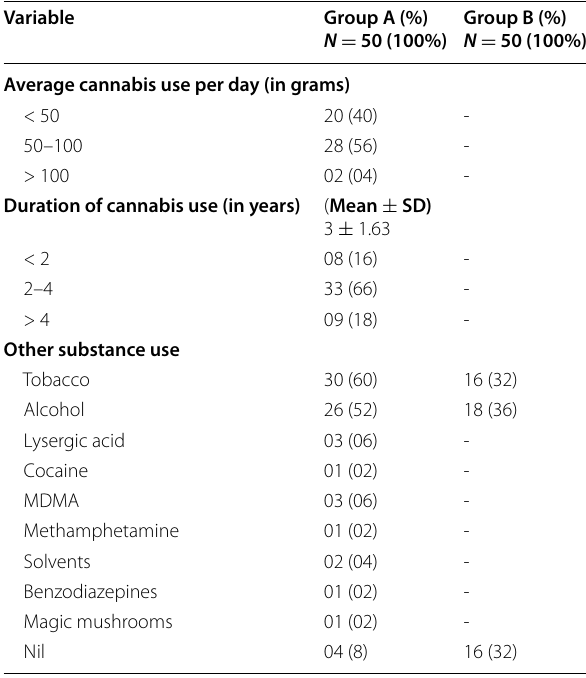
Table 6 Relationship between cannabis use and MoCA